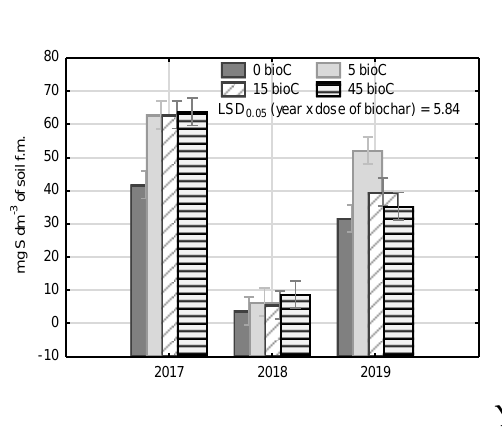
Figure 2. Soil reaction (pH), salt concentration (EC), and macronutrient content (mg dm − 3 ) in the soil depending on the applied biochar dose in 2017 – 2019 (average of nitrogen doses).